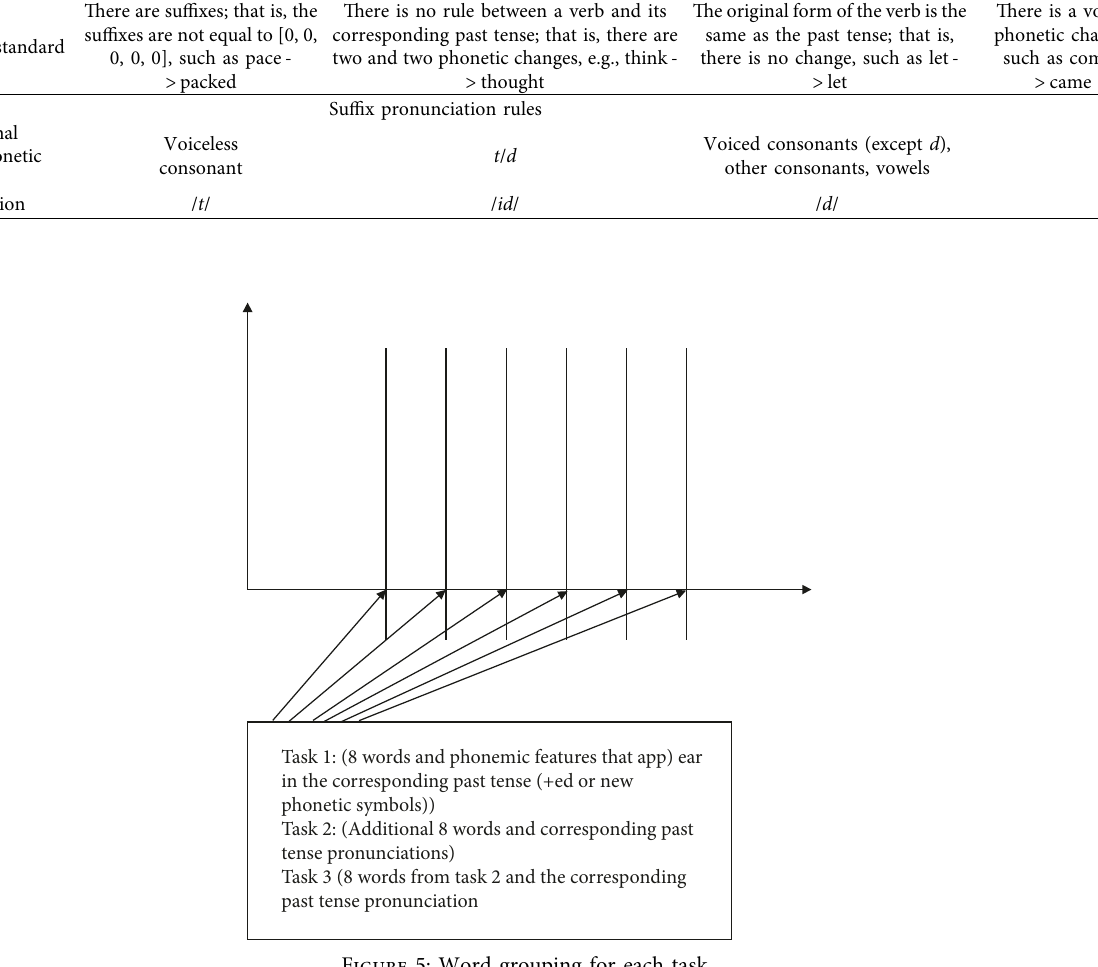
Figure 5: Word grouping for each